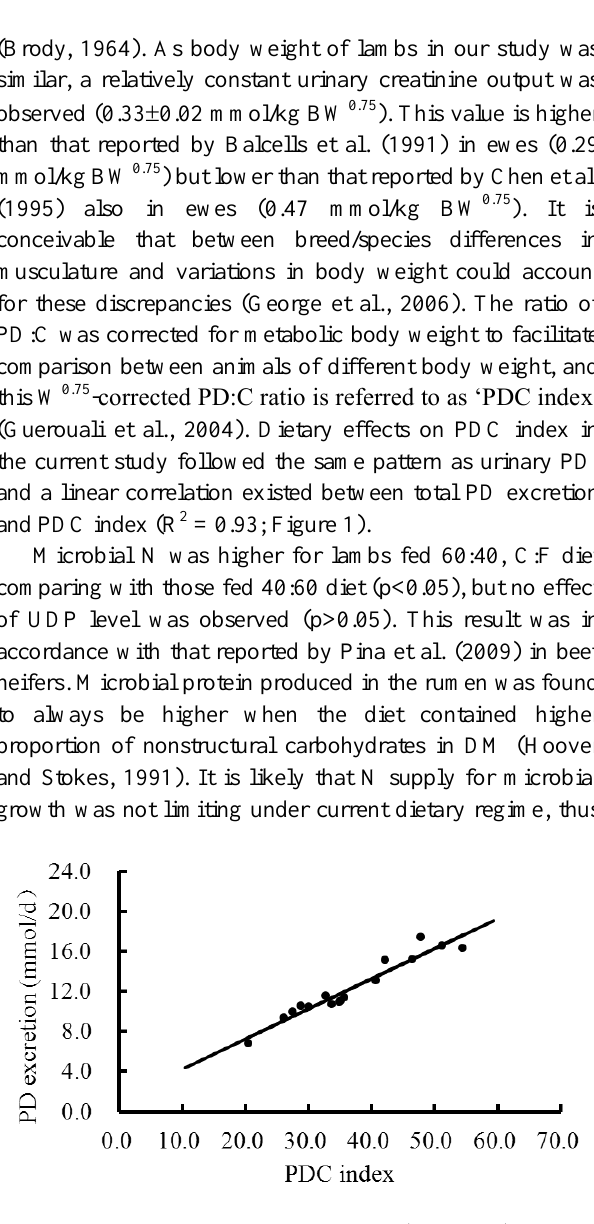
Figure 1. Correlation between PD excretion (Y, mmol/d) and PDC index (X) in total urine of lambs fed diets differing in C:F and level of UDP: Y = 0.30X+1.21, R 2 =